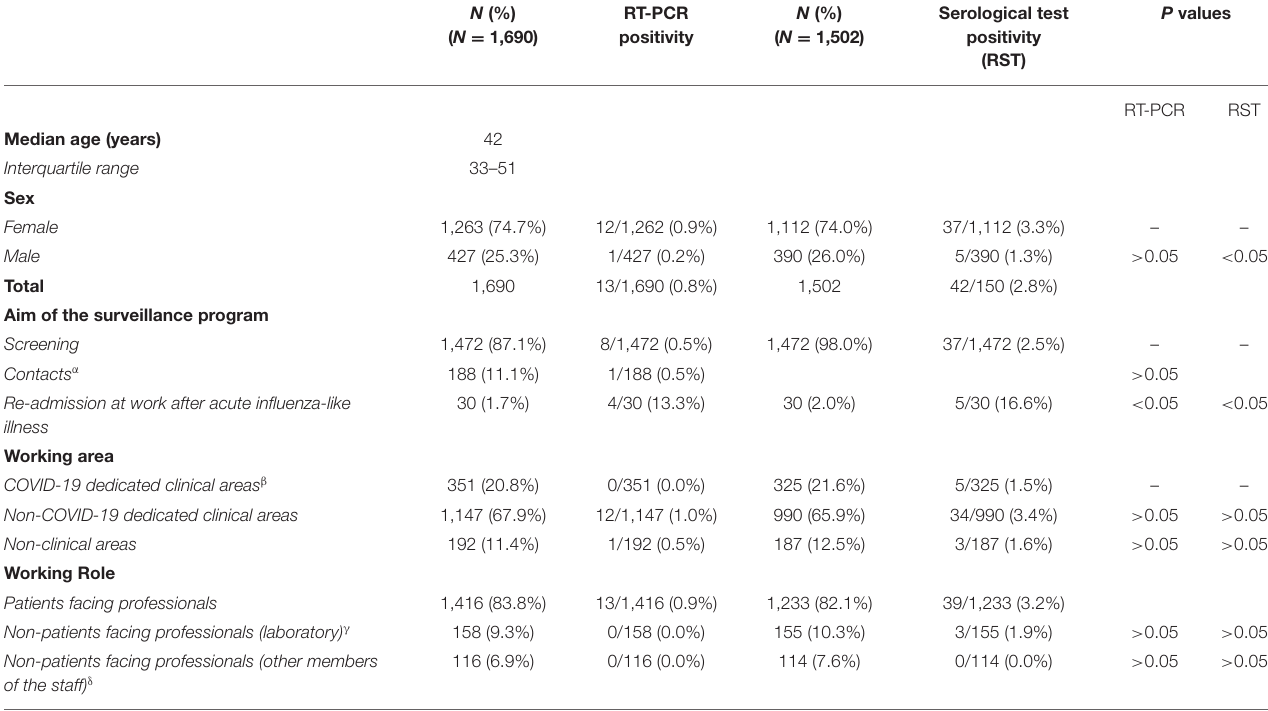
TABLE 1 | Characteristics of the cohort of workers, during the surveillance program (April 2–May 6, 2020) according to real-time PCR (RT-PCR) on nasopharyngeal (NP) swabs and rapid serological test (RST) results.